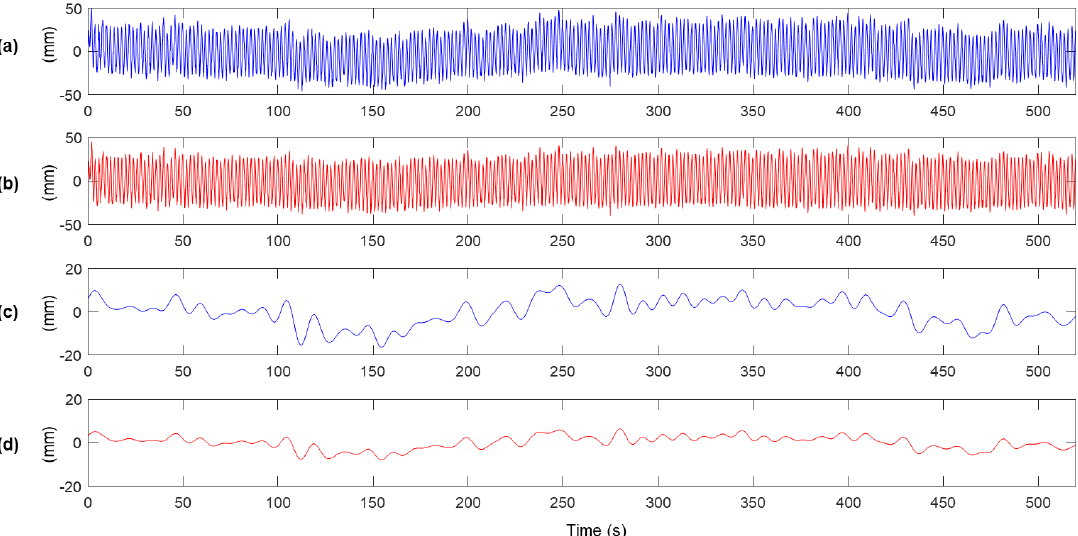
Figure 8. Comparison of low-frequency error before and after MHDR is applied: ( a ) 𝑥 𝑚𝑟 (𝑘) , ( b ) 𝑥 ℎ𝑟 (𝑘) , ( c ) 𝑥 𝑙𝑟 (𝑘) , and ( d ) 𝑥 𝑙ℎ𝑟 (𝑘) .